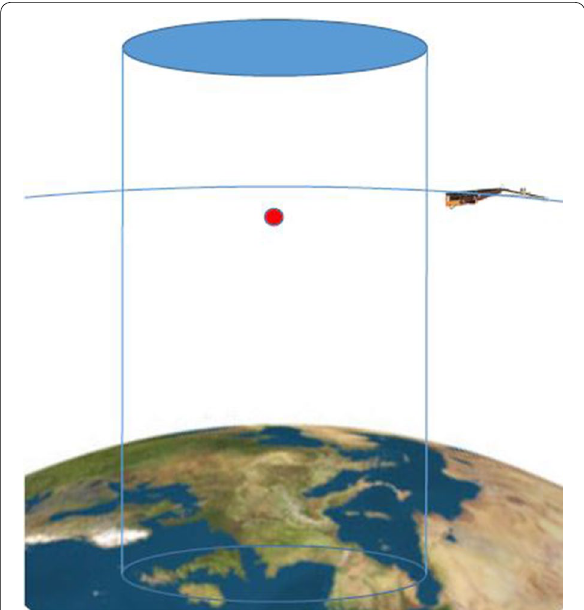
Fig. 1 Illustration of the Geomagnetic Virtual Observatory concept; satellite magnetic measurements from within a target cylinder are used to infer field time series at the GVO location given by a red dot. Note the cylinder radius is not to scale, the actual cylinder footprints are shown in Fig.